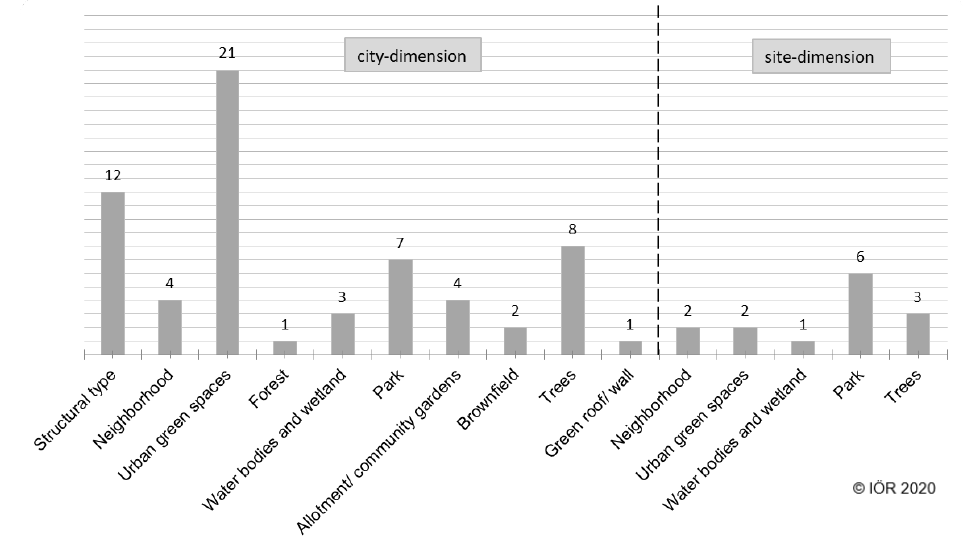
Figure 3. Urban green infrastructure types investigated by the articles, subdivided into city- ( left ) and site-dimension ( right ).